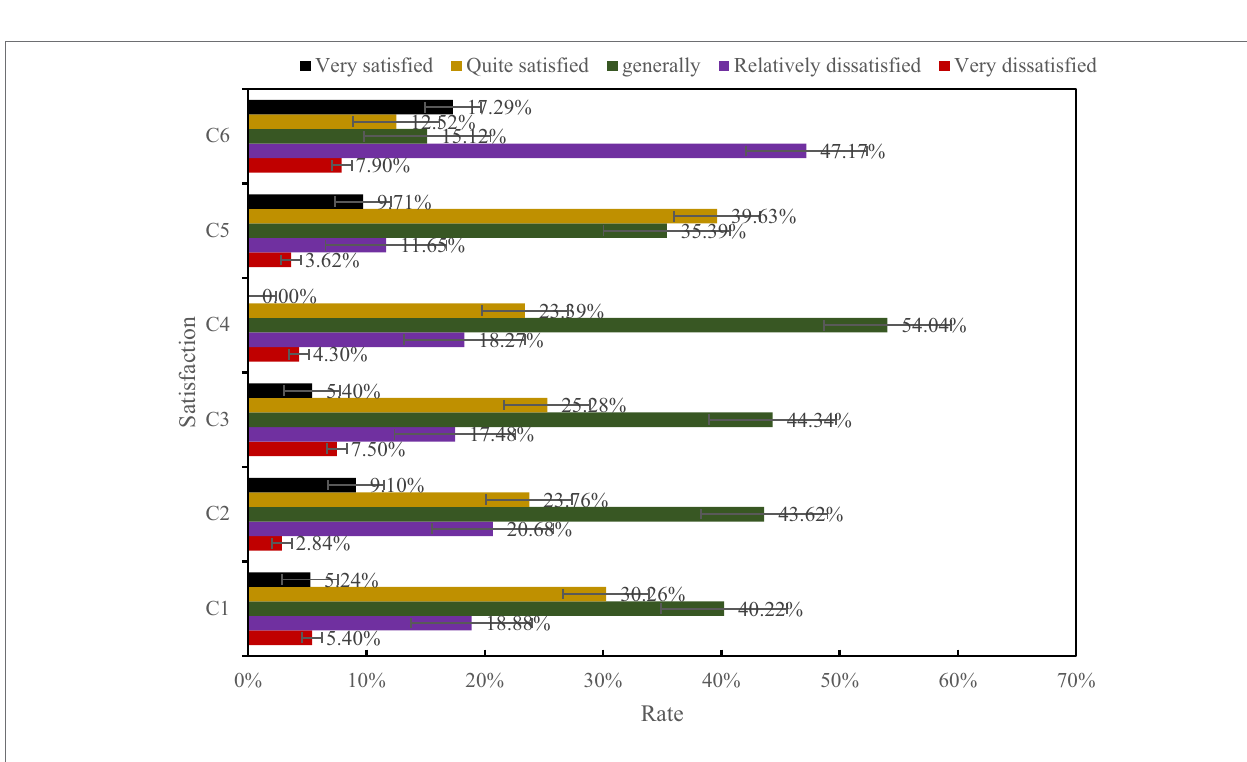
FIGURE 9 | Teaching evaluation psychology management student satisfaction